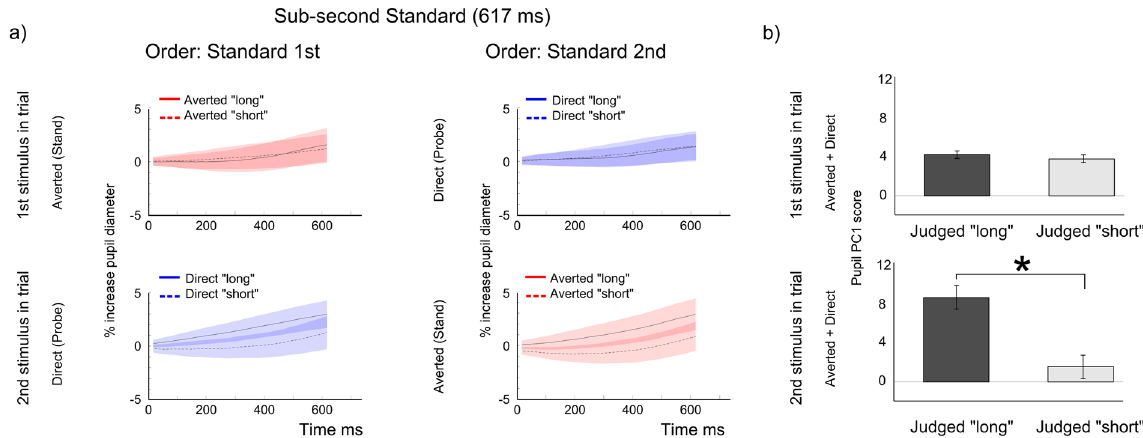
Figure 2. ( a ) Averaged pupil responses during the direct and averted duration encoding epochs as a function of duration judgement (longer or shorter) and stimulus order (Standard 1 st : averted 1 st – direct 2 nd , or, Standard 2 nd : direct 1 st – averted 2 nd ). ( b ) Pupil PC1 score as a function of duration judgement (longer or shorter). Error bars depict the Standard Error of the Mean